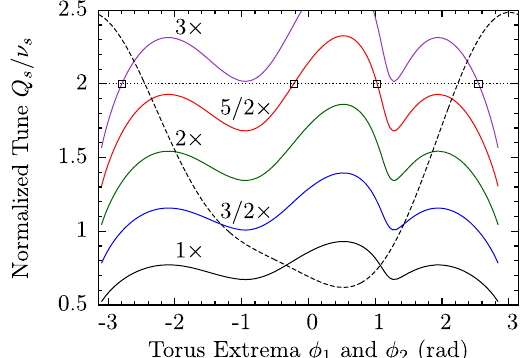
= ν FIG. 5. Normalized synchrotron tune Q as a function of the s s = ν as a function of ¼ 2 horizontal dotted-line intercepts depict s s = ν action J . The ν ¼ 2 horizontal dotted-line m s = ν m s the location of n ∶ M parametric resonances driven by phase modulation where the double rf parameters are r ¼ 1 = 2 , h ¼ 2 , ¼ 30 °.The initial location ofthebunchatthe origin ofthe and Δ ϕ o where the double s primary-rf-only phase space corresponds to the action J ¼ 0 . 092 ¼ 30 °. o